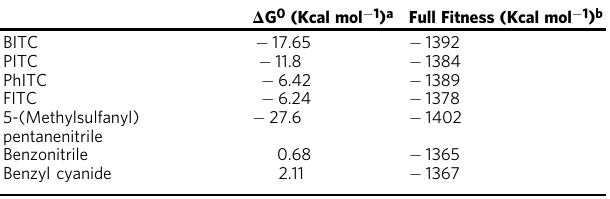
and lesion sizes were analyzed using ASSESS 2.0 image analysis software for plant disease quanti fi cation (APS Press). Yeast strain and growth conditions . S. cerevisiae BY4742 ( MAT α , his 3 Δ 1, leu 2 Δ 0, lys 2 Δ 0, ura 3 Δ 0) (kindly provided by Dr. Juergen Stolz, Technical Uni- versity of Munich, Germany) yeast cells were grown in YPD (2% peptone, 2% glucose/galactose, 1% yeast extract, w per v) or YNB (2% galactose/glucose and 0.67% yeast nitrogen base, w per v) medium at 30°C. ITC inhibition of radial mycelial growth in vitro . The inhibitory effect of ITCs on mycelial growth of B. cinerea (B05.10), Δ mfsG and the complemented mutants was tested by placing a 6-mm diameter plug from 3-day-old B. cinerea colony margins